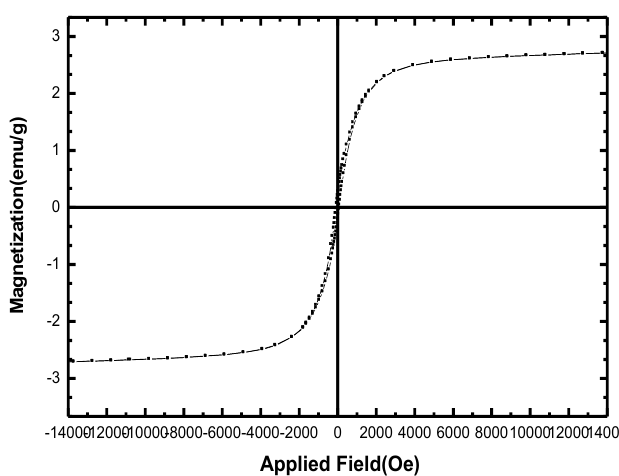
Fig. 9. Hysteresis loop of PS-CuFe